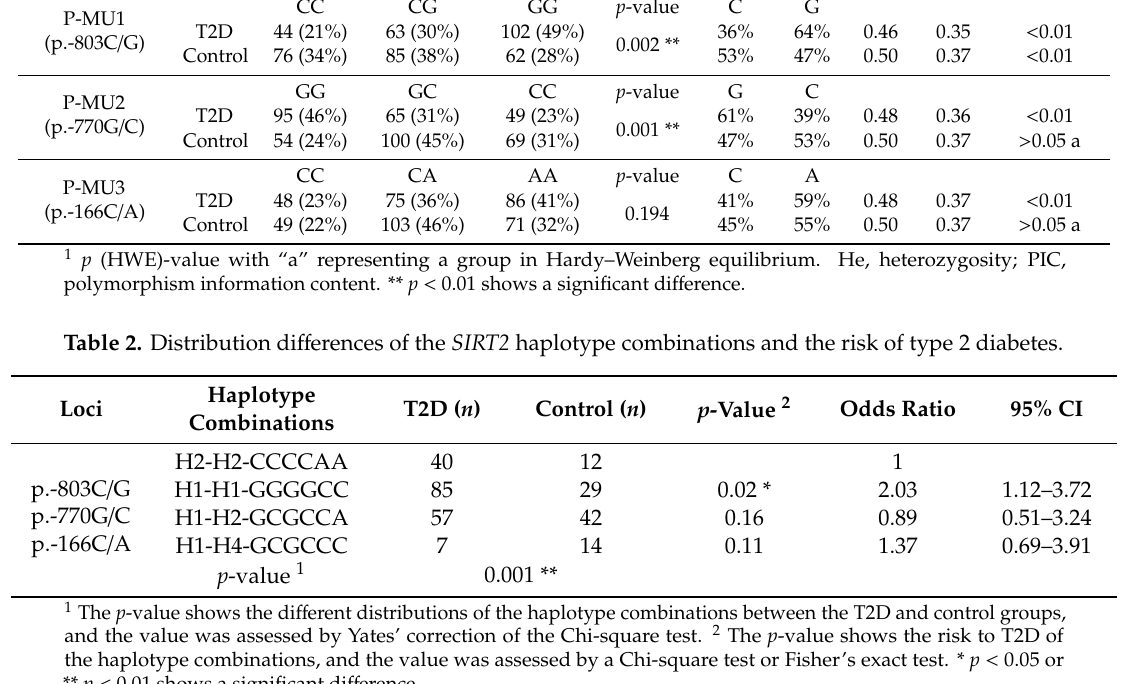
Table 1. Population genetic information of the SIRT2 SNPs in T2D patients and healthy controls. Loci Group